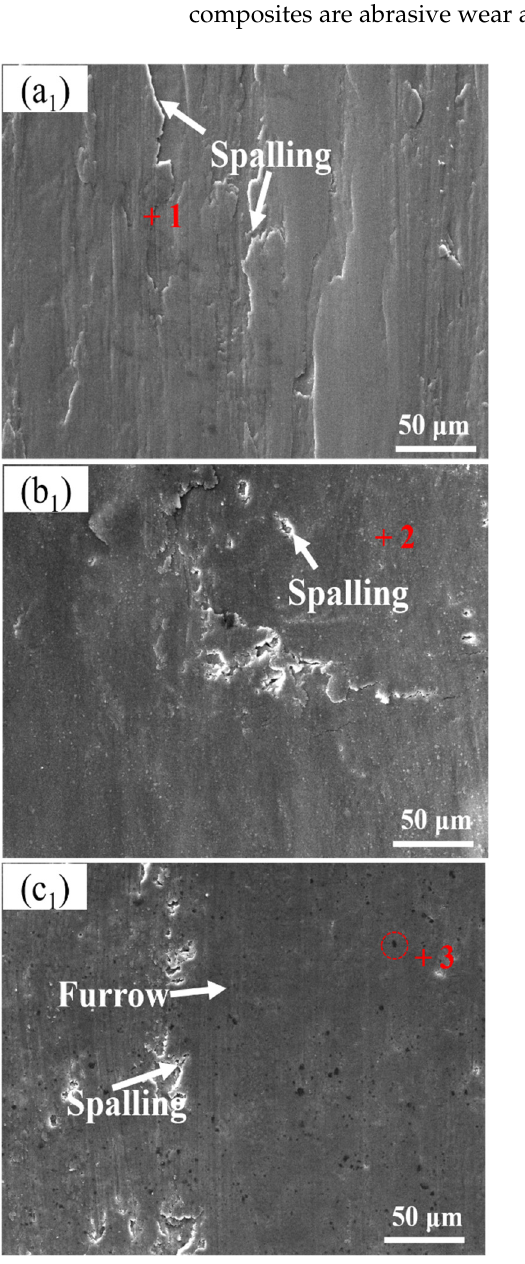
Figure 5. Worn surface analysis of samples after wear test at room temperature. ( a1 ) Worn surface of Al 7075; ( a2 ) 3D laser scanning topography of Al 7075. ( b1 ) worn surface of 15 wt.% VN/7075; ( b2 ) 3D laser scanning topography of 15 wt.% VN/7075; ( c1 ) worn surface of 20 wt.% TiB 2 -TiC x /7075; ( c2 ) 3D laser scanning topography of 20 wt.% TiB 2 -TiC x